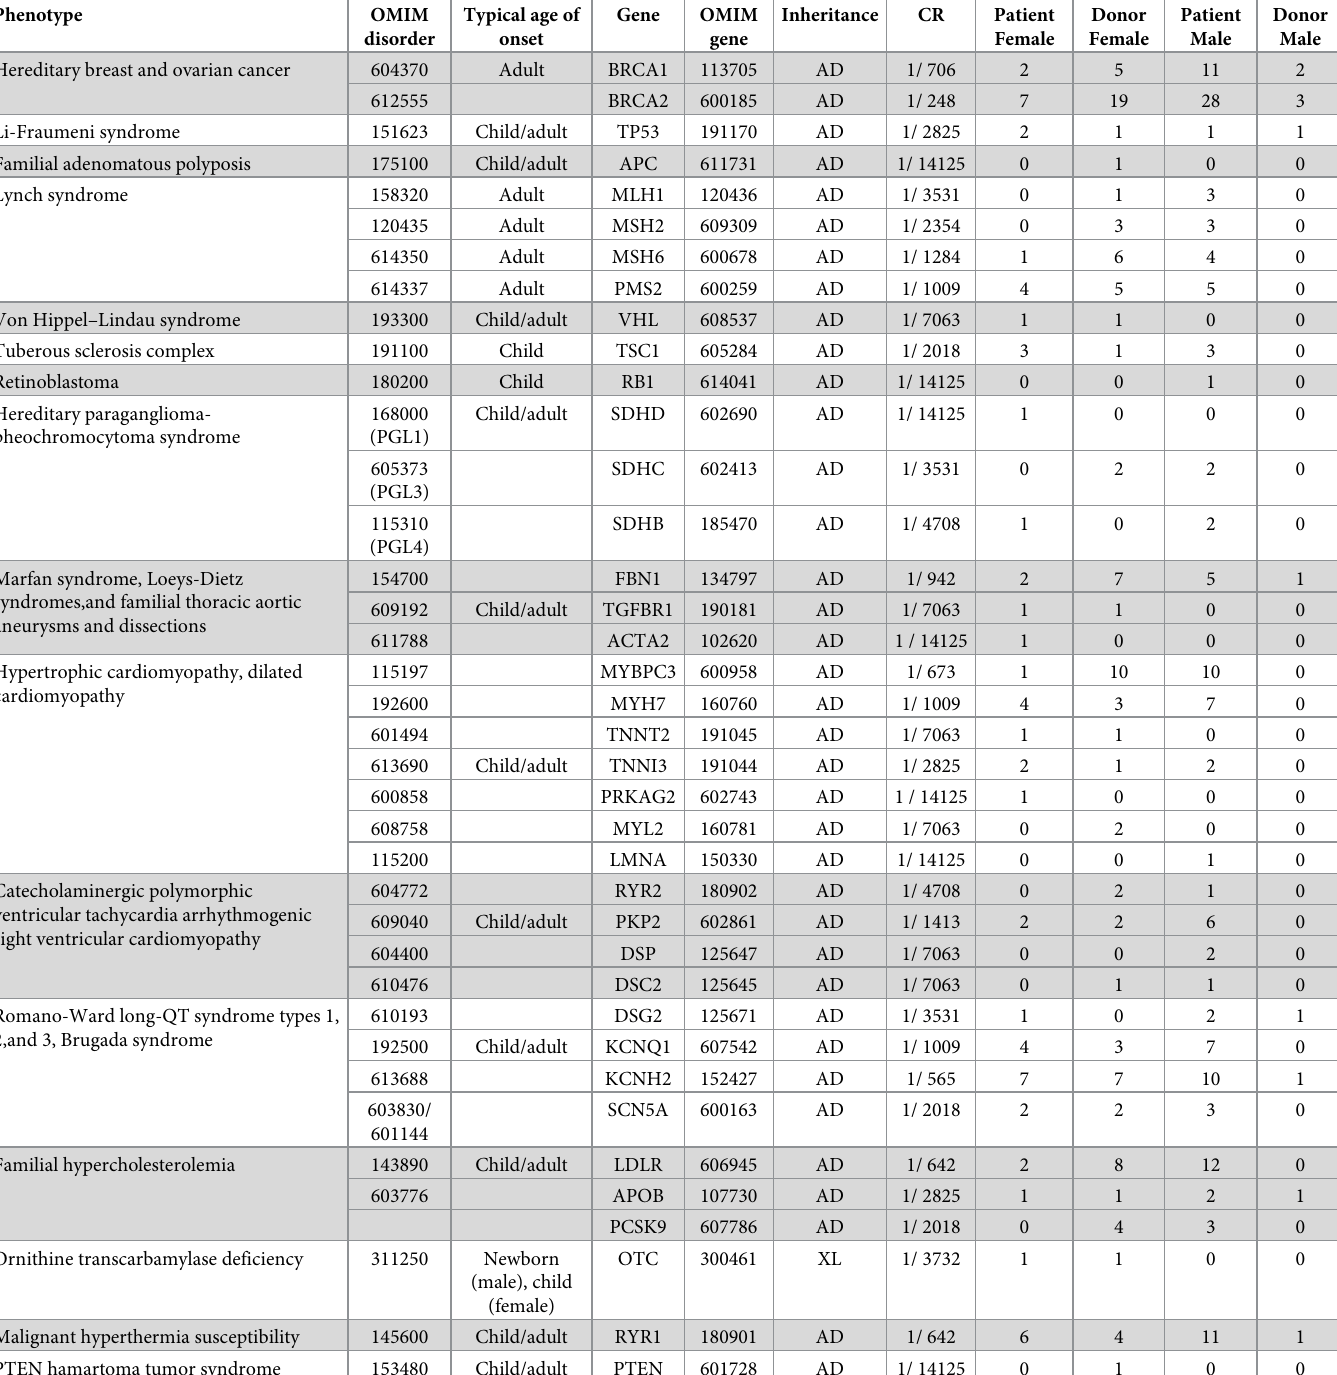
Table 2. Detection of secondary findings from exome sequencing of 14,125